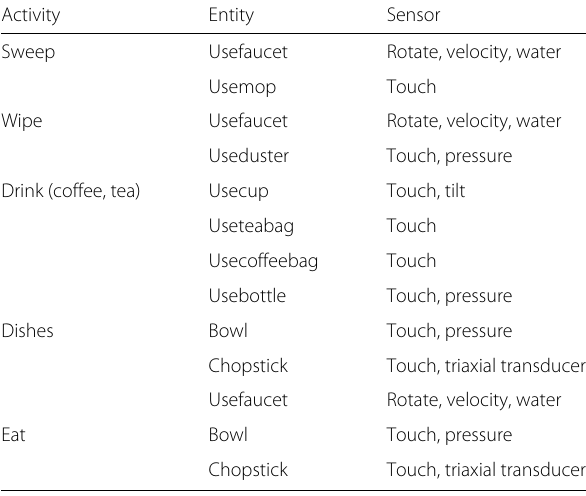
Table 2 Activity-entity-sensor design for five